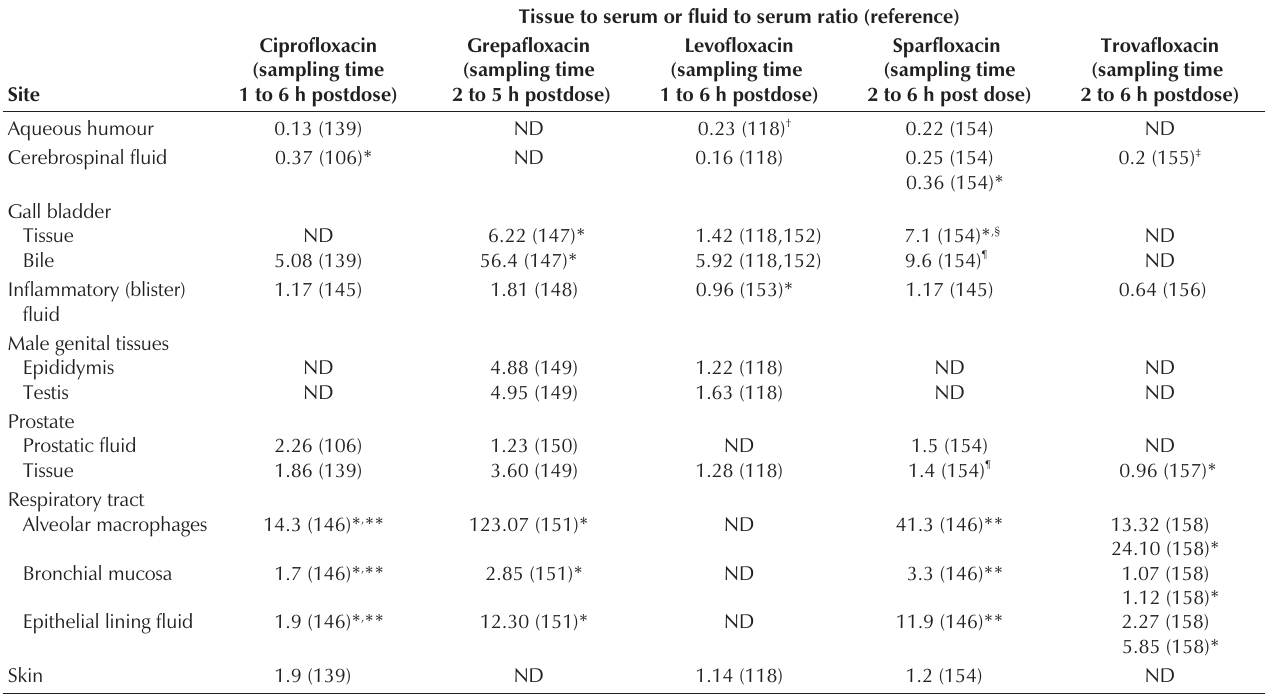
Penetration of the new fluoroquinolones and ciprofloxacin into selected fluids and tissues Tissue to serum or fluid to serum ratio